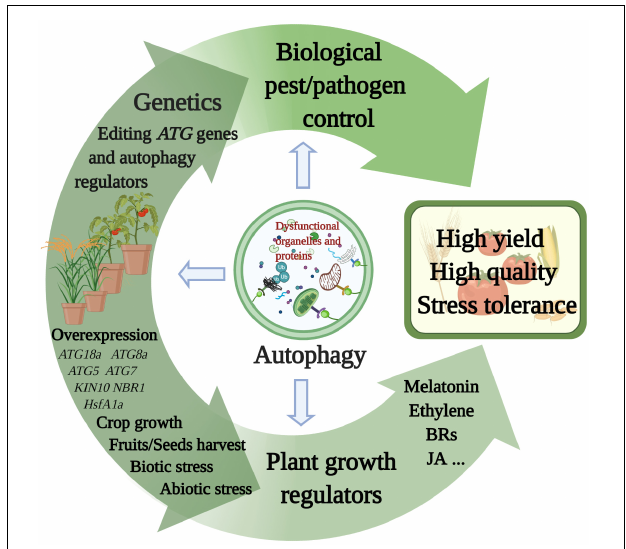
FIGURE 3 | Multiple proposed agricultural applications related to autophagy. Each of the methods described in the main text explores a component of autophagy function. Superior yield, quality, and stress resistance characteristics will emerge in various crop species from autophagy applications via genetic research, plant growth regulators, and biological pest and pathogen control. This figure was created by BioRender